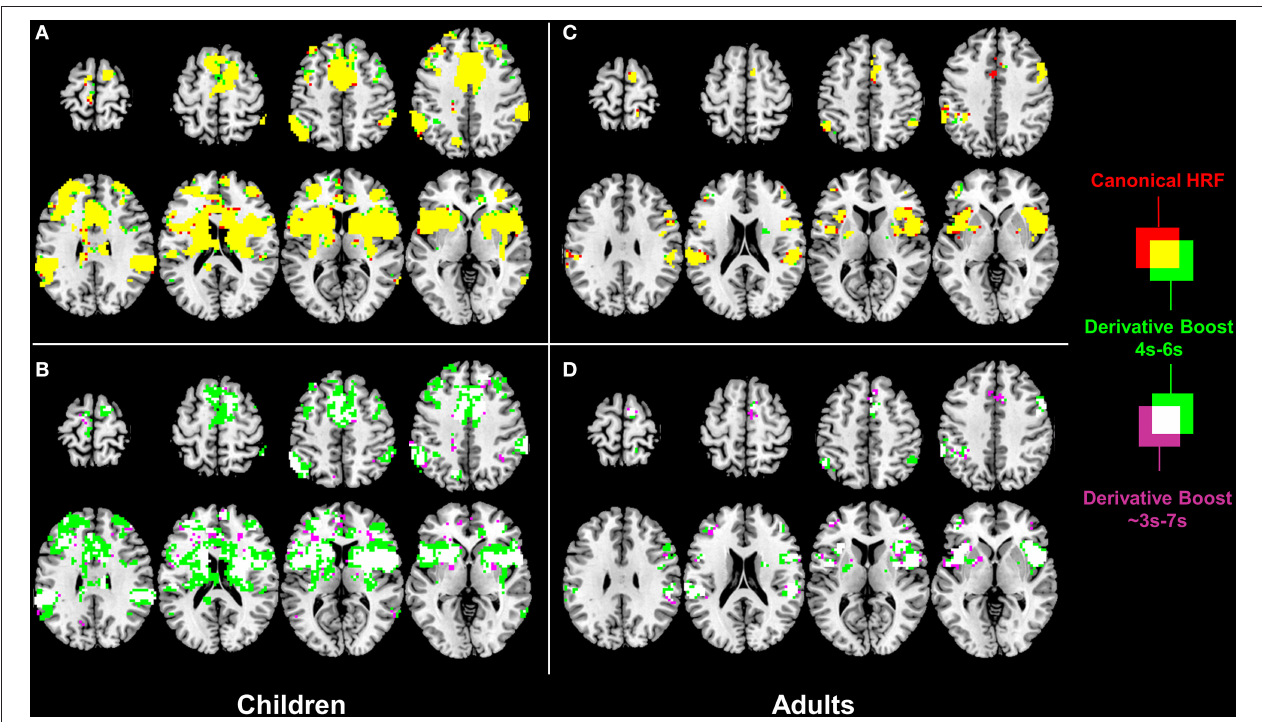
FIGURE 3 | Effect of derivative boost on proprioceptive mapping (one-sample t -maps) in the 100Hz condition. (A,C) Mapping obtained using the canonical HRF alone (red) and the derivative boost constrained between 4 and 6s (green) in children and adults. Overlapping active voxels (i.e., conjunction) are represented in yellow. (B,D) Impact of the absence of constraints on the derivative boost (i.e., the full time range covered by the basis set, as represented in purple) in children and adults. Overlapping active voxels between the two derivative boosts are represented in white. Maps are thresholded at a voxel-wise threshold of p < 0.001 uncorrected and a cluster extend threshold of p < 0.05